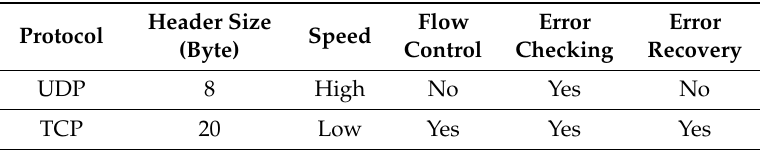
Table 2. Comparison of communication protocols [18]. (Flow control is the ability to delay packet transmission to go back and request that a dropped packet is resent.)